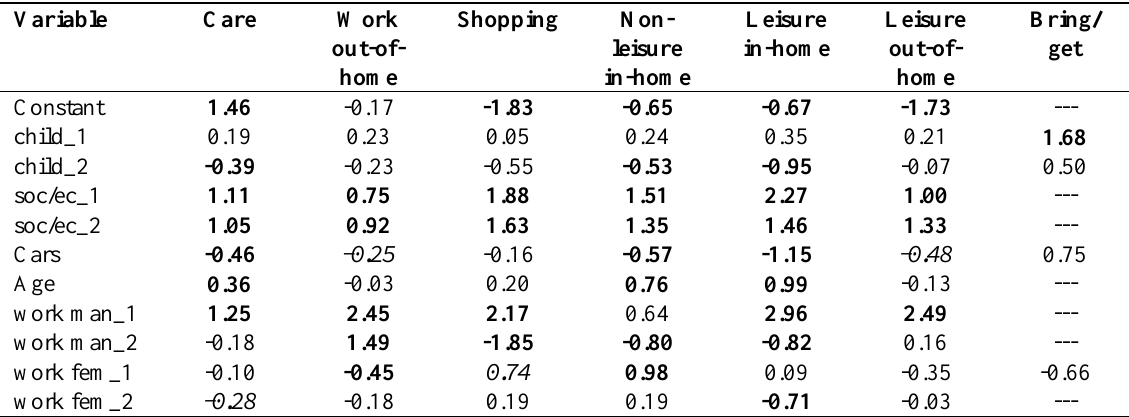
Table 3. Effects of the independent variables on the time allocation of